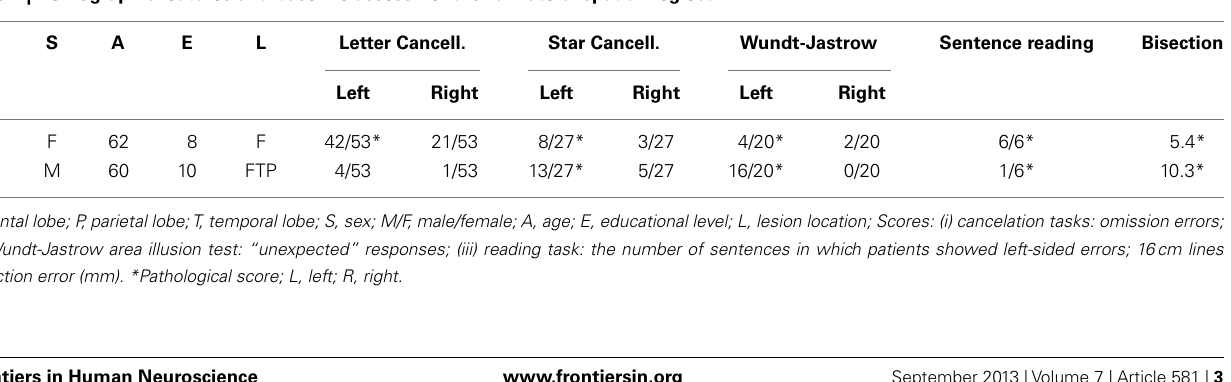
Table 1 | Demographic features and baseline assessment for unilateral spatial neglect. Pat. Star Cancell.